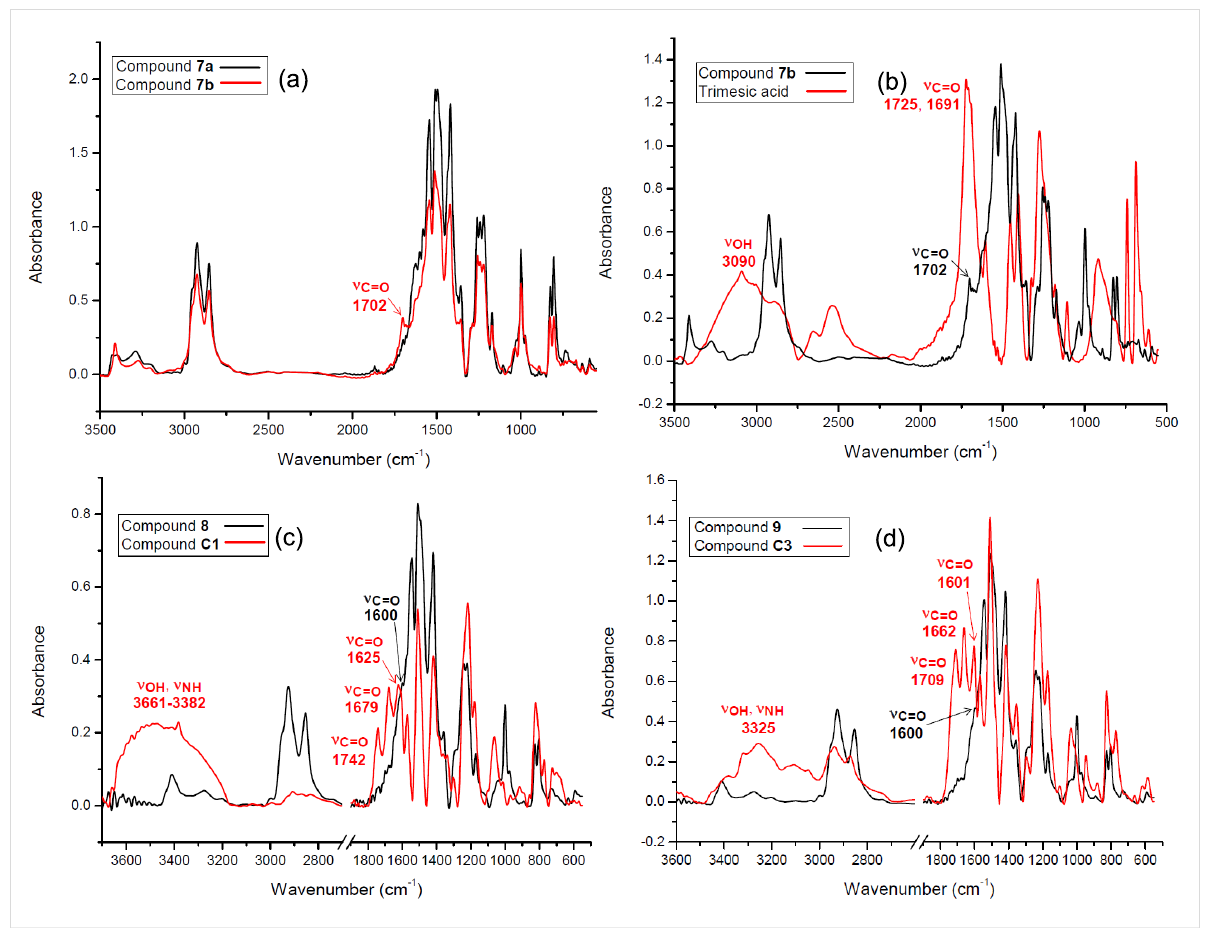
Figure 4: Comparative IR spectra (KBr) of compounds 7a vs 7b (a), 7b vs trimesic acid (b), 8 vs C1 (c) and 9 vs C3 (d).